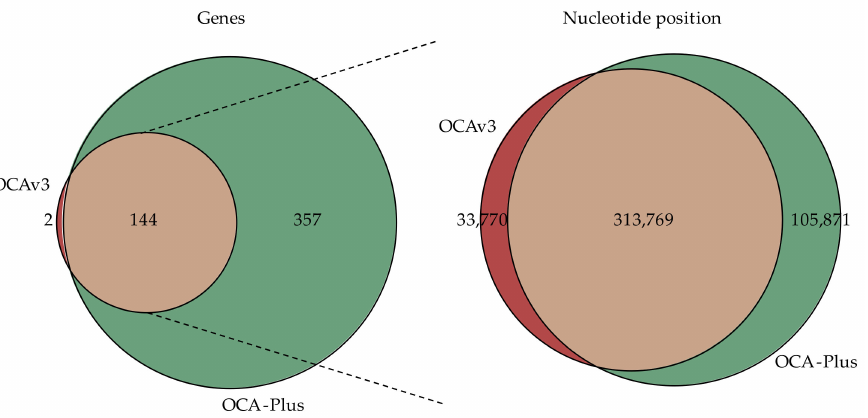
Figure 1. Identification of overlapping genes and overlapping locus positions. Genes and amplicon coverage of nucleotide positions were extracted from Oncomine™ Comprehensive Assay v3 and Oncomine™ Comprehensive Assay Plus browser extensible data files, respectively. From left to right: Venn diagram showing that 144 genes are intersecting between OCAv3 and OCA-Plus. Out of the 144 genes, 313,769 nucleotide positions are covered in both OCAv3 and